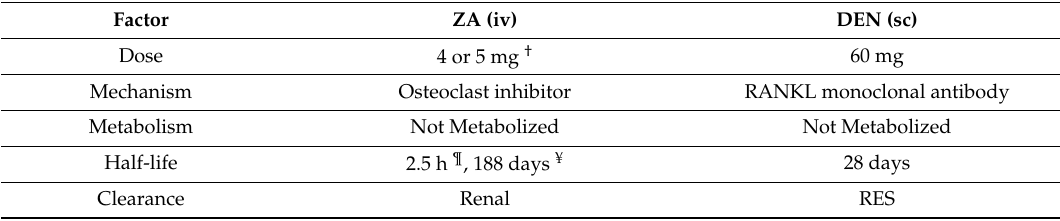
Table 3. Comparisons between zoledronic acid and